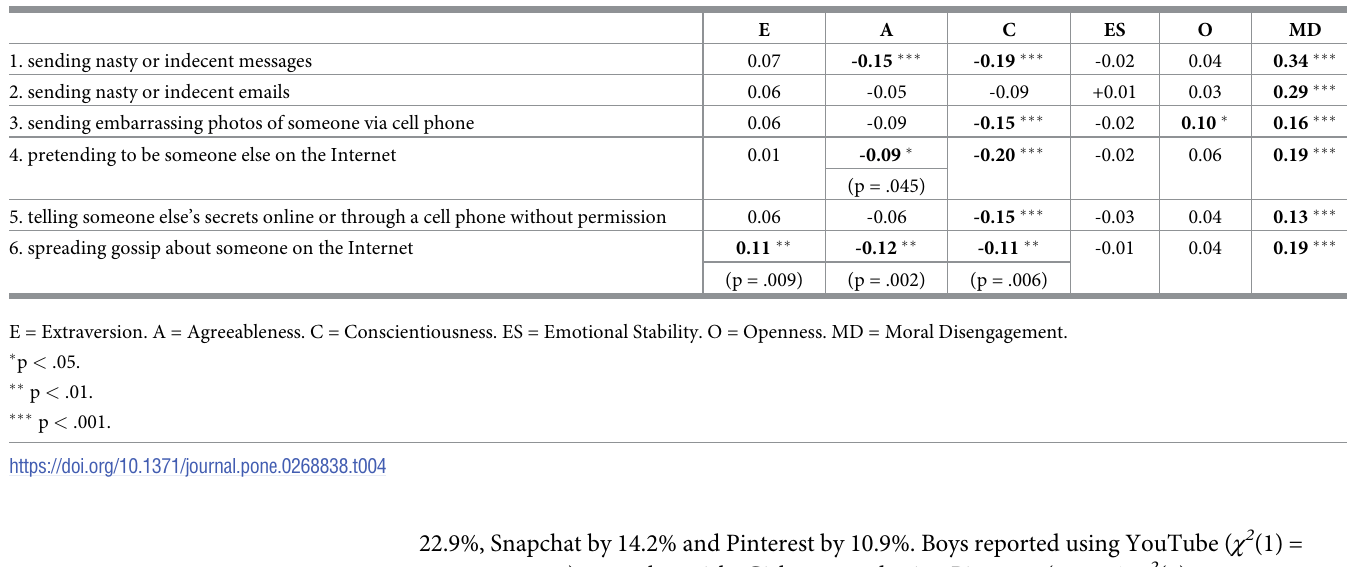
Correlations between cyberbullying and personality RQ3 . Are different types of cyberbullying behaviours specifically related to different profiles of internet and social media usage ?